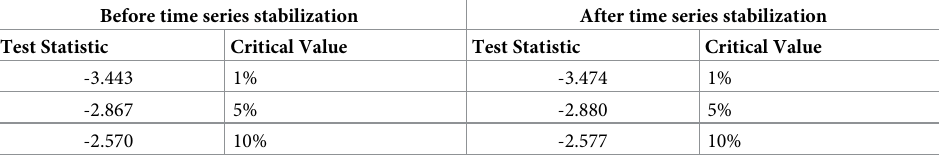
Table 1. Test statistics of time series before and after stabilization under confidence